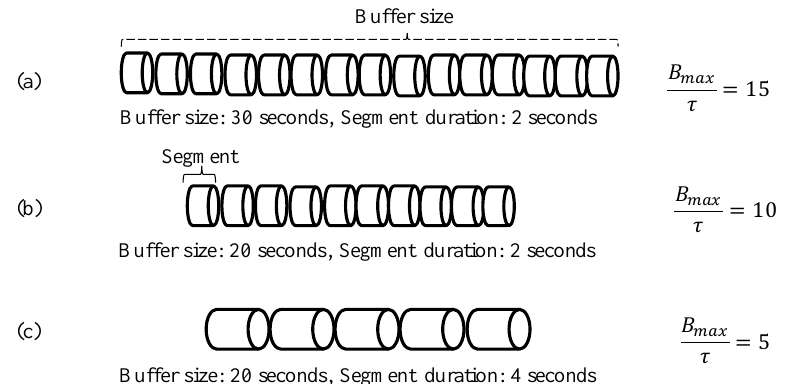
Figure 2. Comparing ( a , b ) shows that the larger buffer size allows the client to buffer more segments. Comparing ( b , c ) shows that longer segment durations decrease the number of segments that can be buffered.